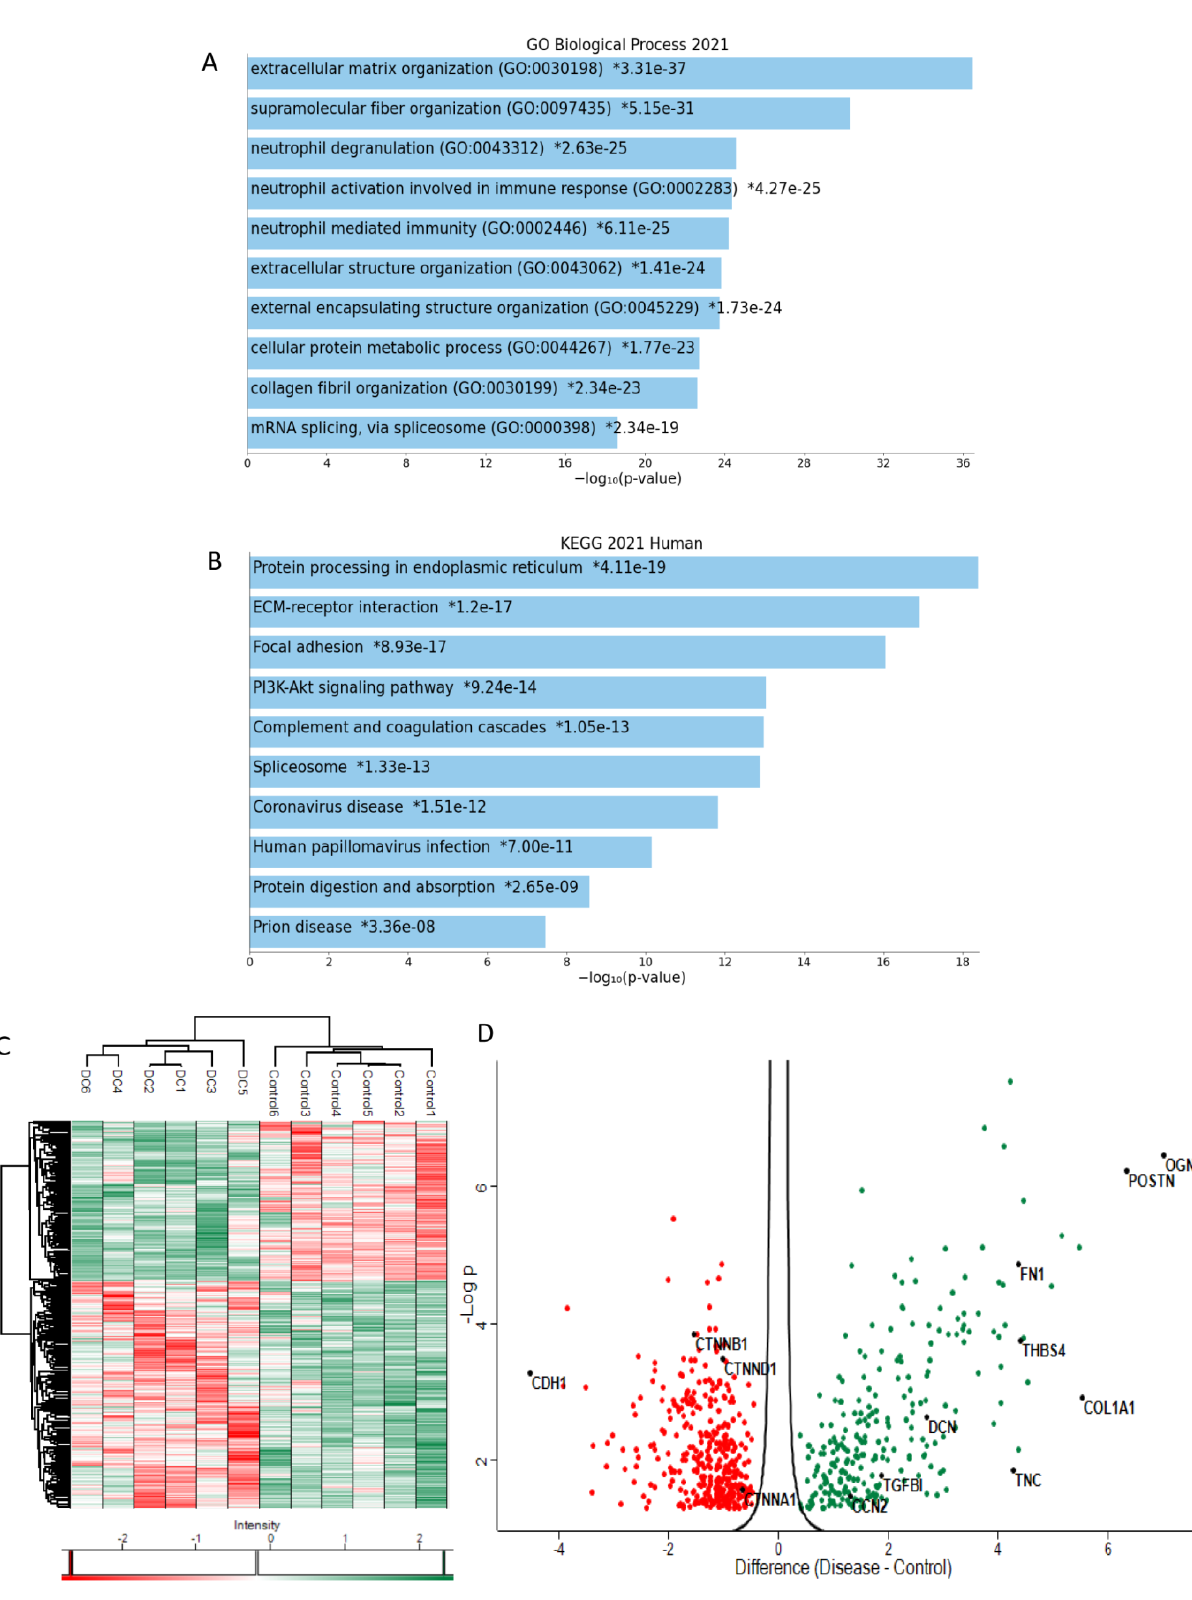
Figure 1. Proteomic analysis of sweat glands obtained from Dupuytren’s contracture. Enrichment analysis GO Biological process ( A ) and Kyoto Encyclopedia of Genes and Genomes pathways related ( B ). The bar chart shows the top 10 enriched terms, along with their corresponding p -values (*; p < 0.05). Heat map ( C ) and volcano plot ( D ) of proteomic analysis.